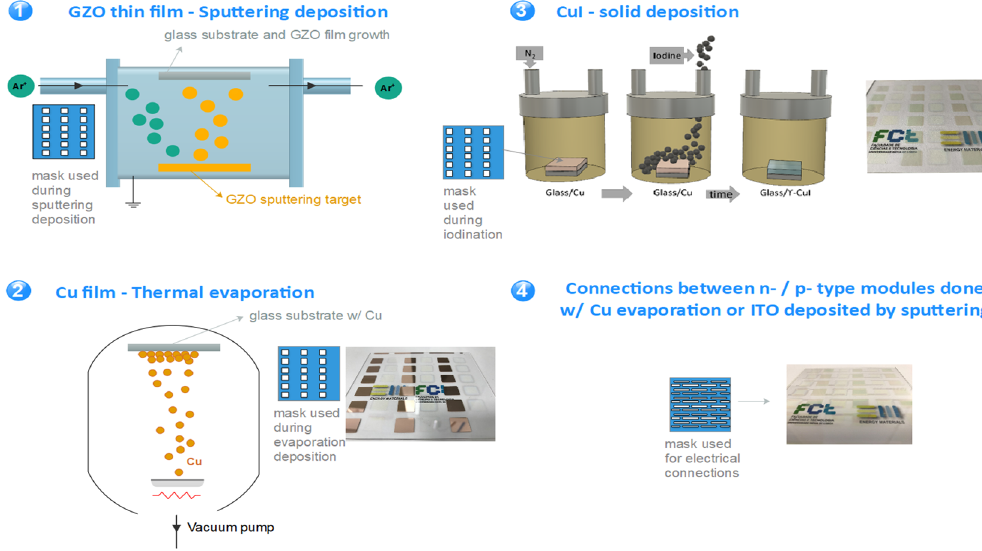
Figure 8. A schematic representation of the fabrication process of the first fully transparent TEG made of p - type CuI and n -type GZO elements electrically connected in-series and thermally in parallel.